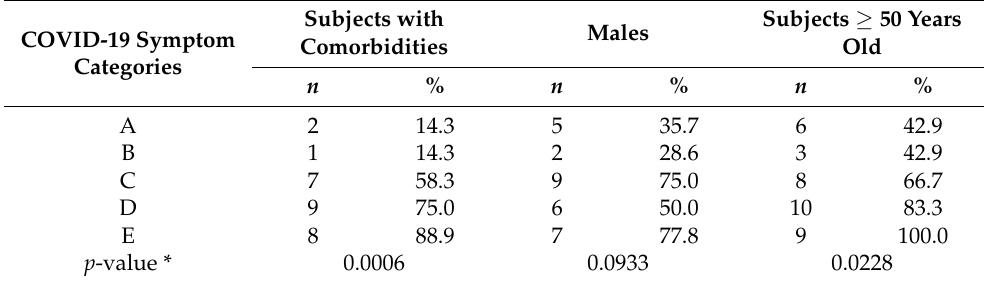
Table 4. Presence of comorbidities, sex and age of subjects within each COVID-19 symptom category. COVID-19